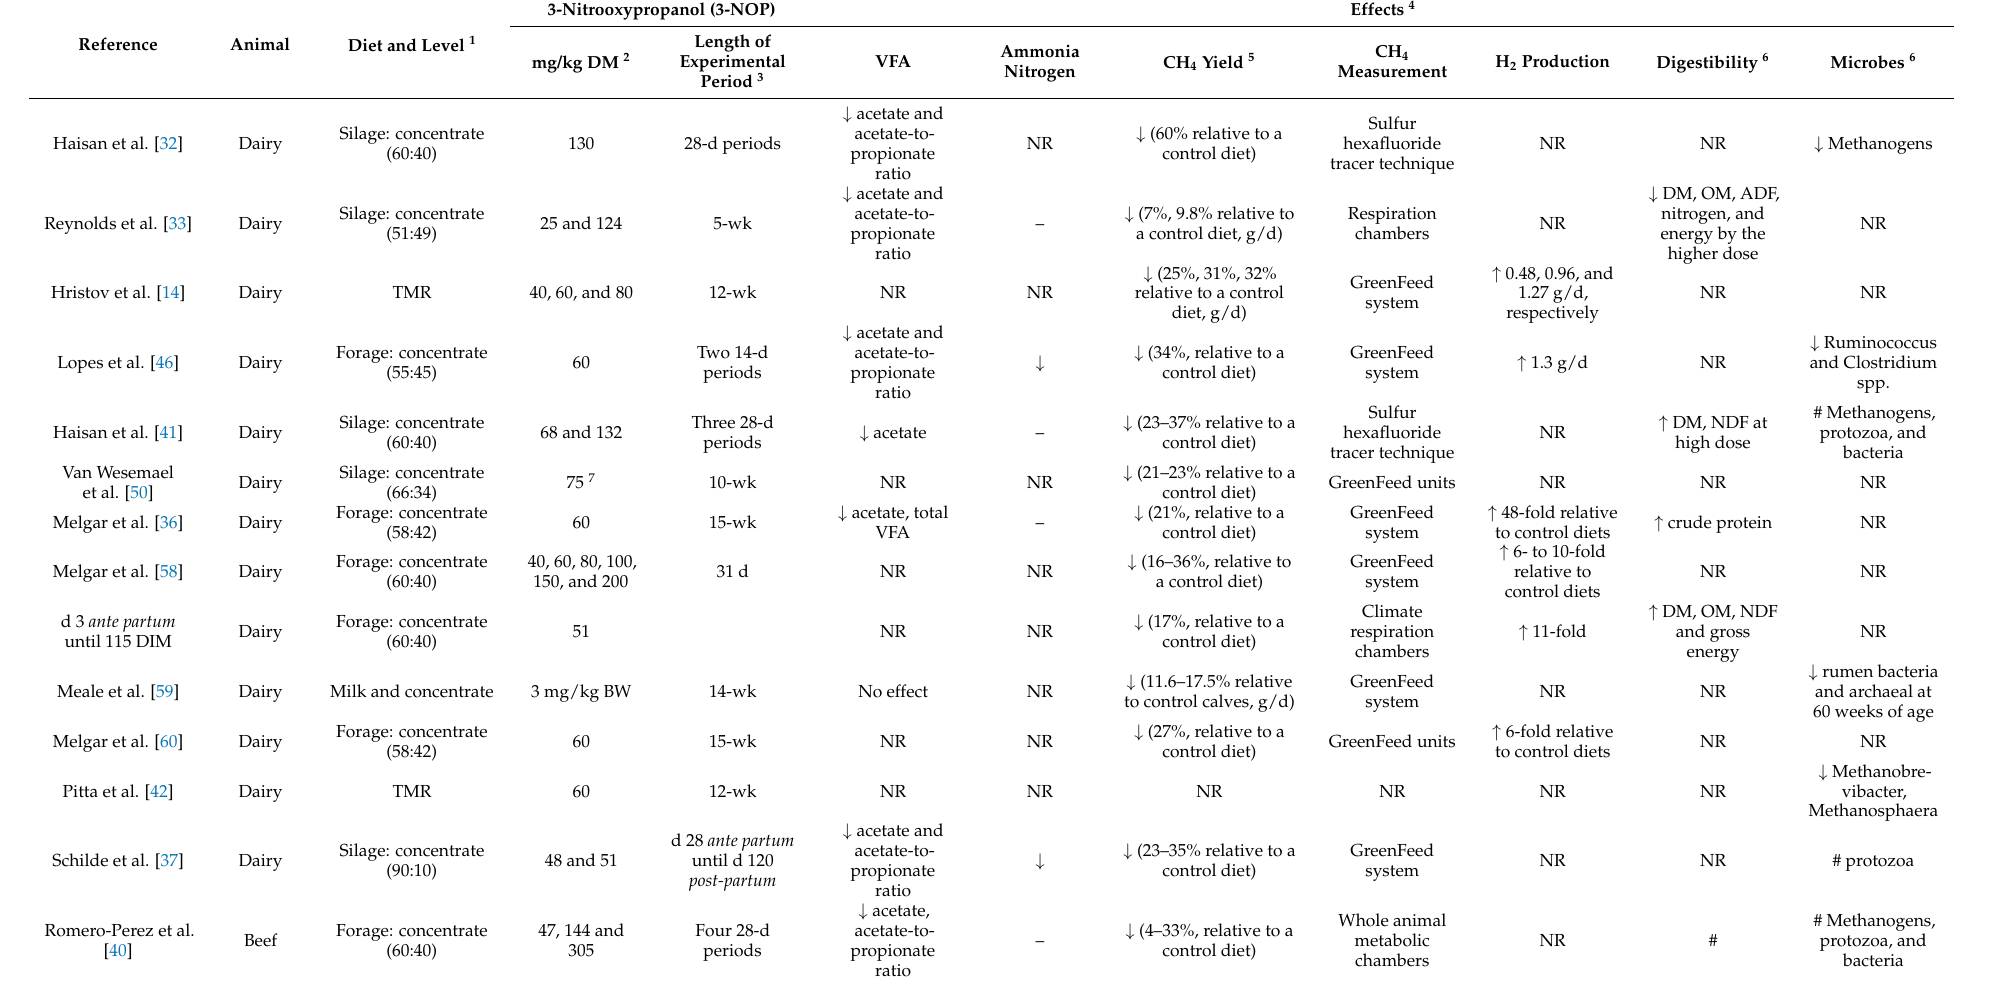
Table 2. Summary of 3-nitrooxypropanol (3-NOP) effects on in vivo fermentation, digestibility, microbes and enteric CH 4 production in